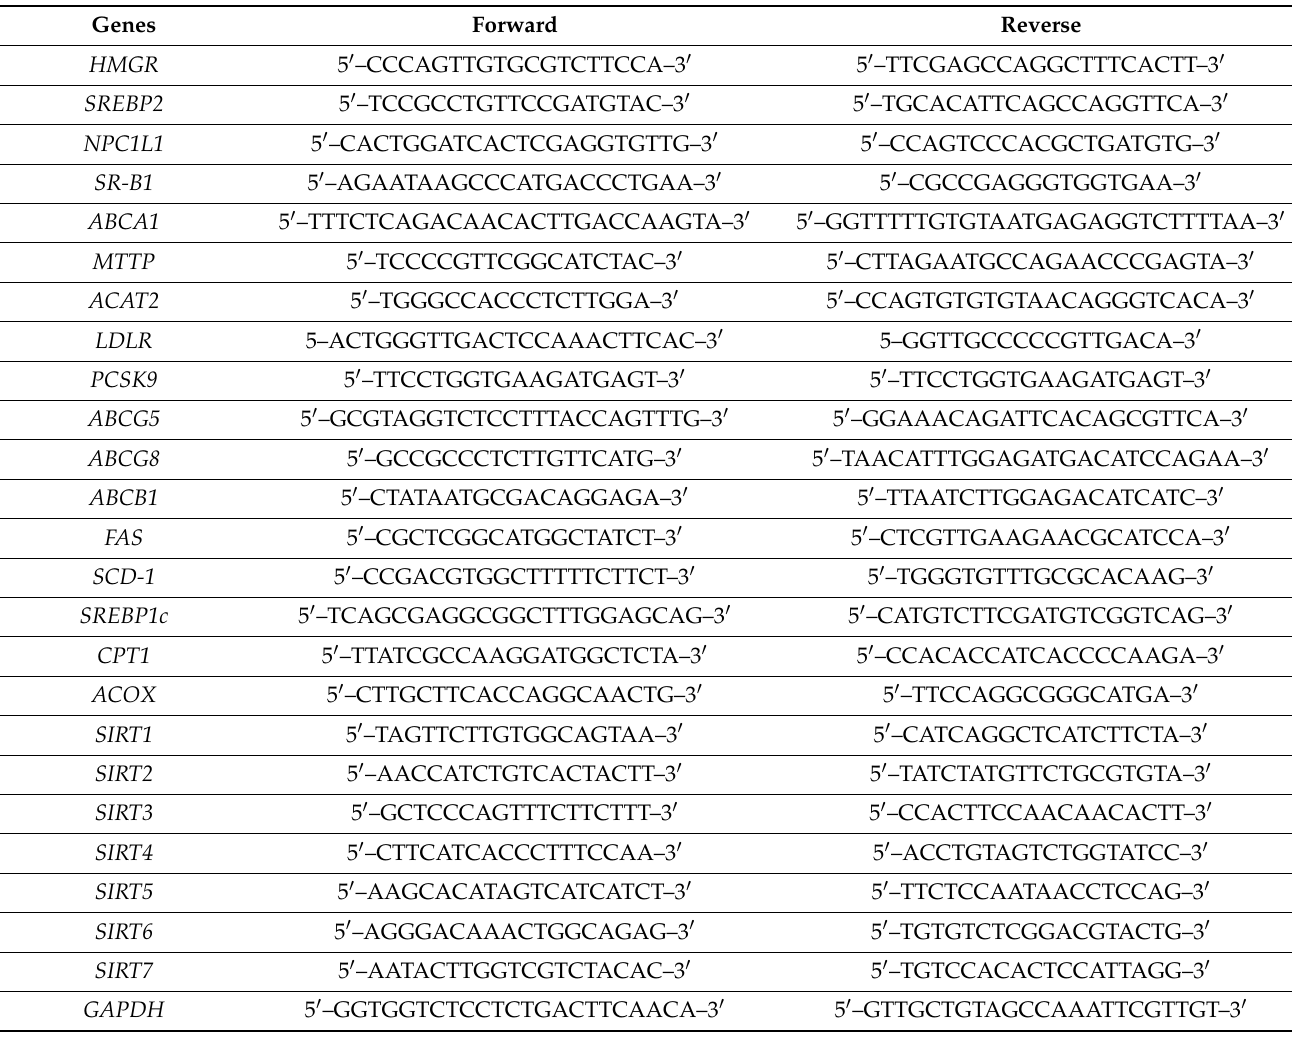
Table 1. The primer sequences for qRT-PCR